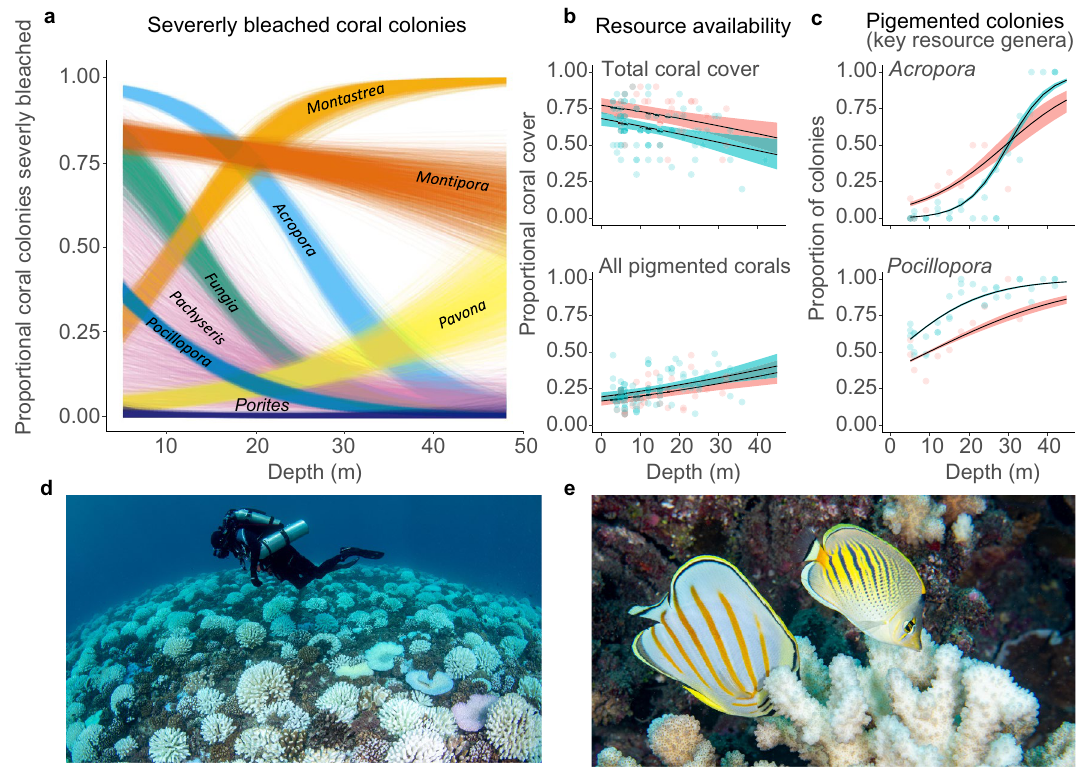
Figure 1. Differing levels of coral bleaching attenuation and health along a shallow to mesophotic depth gradient in Moorea, French Polynesia. ( a ) Variation in the proportion of severely bleached colonies (majority of colony white or with visible algae growing on recently bleached skeleton) among eight coral genera. ( b ) Matching site level depth variation in total coral cover (above) and cover of remaining pigmented corals (below). ( c ) The proportion of colonies remaining pigmented for the two primary prey genera of the focal fish species at the study location. ( d ) A research diver (Bart Shepherd) hovering over extensive coral bleaching during a decompression stop at a shallow study site. ( e ) Two of the focal fish species (Left: Chaetodon ornatissimus; Right: Chaetodon pelewensis ) feeding on a bleached Pocillopora coral in shallow waters. Each line in ( a ) represents 1 of 2000 total draws in a Bayesian sampling model. In ( b ) and ( c ); red (site = Sofitel), blue (site = Rose Garden). Photos: Luiz